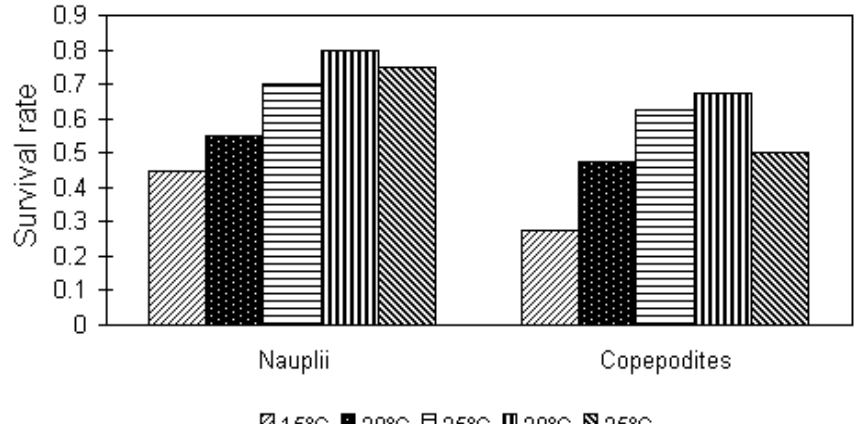
FIGURE 5. Effect of temperature on survival rate of P.